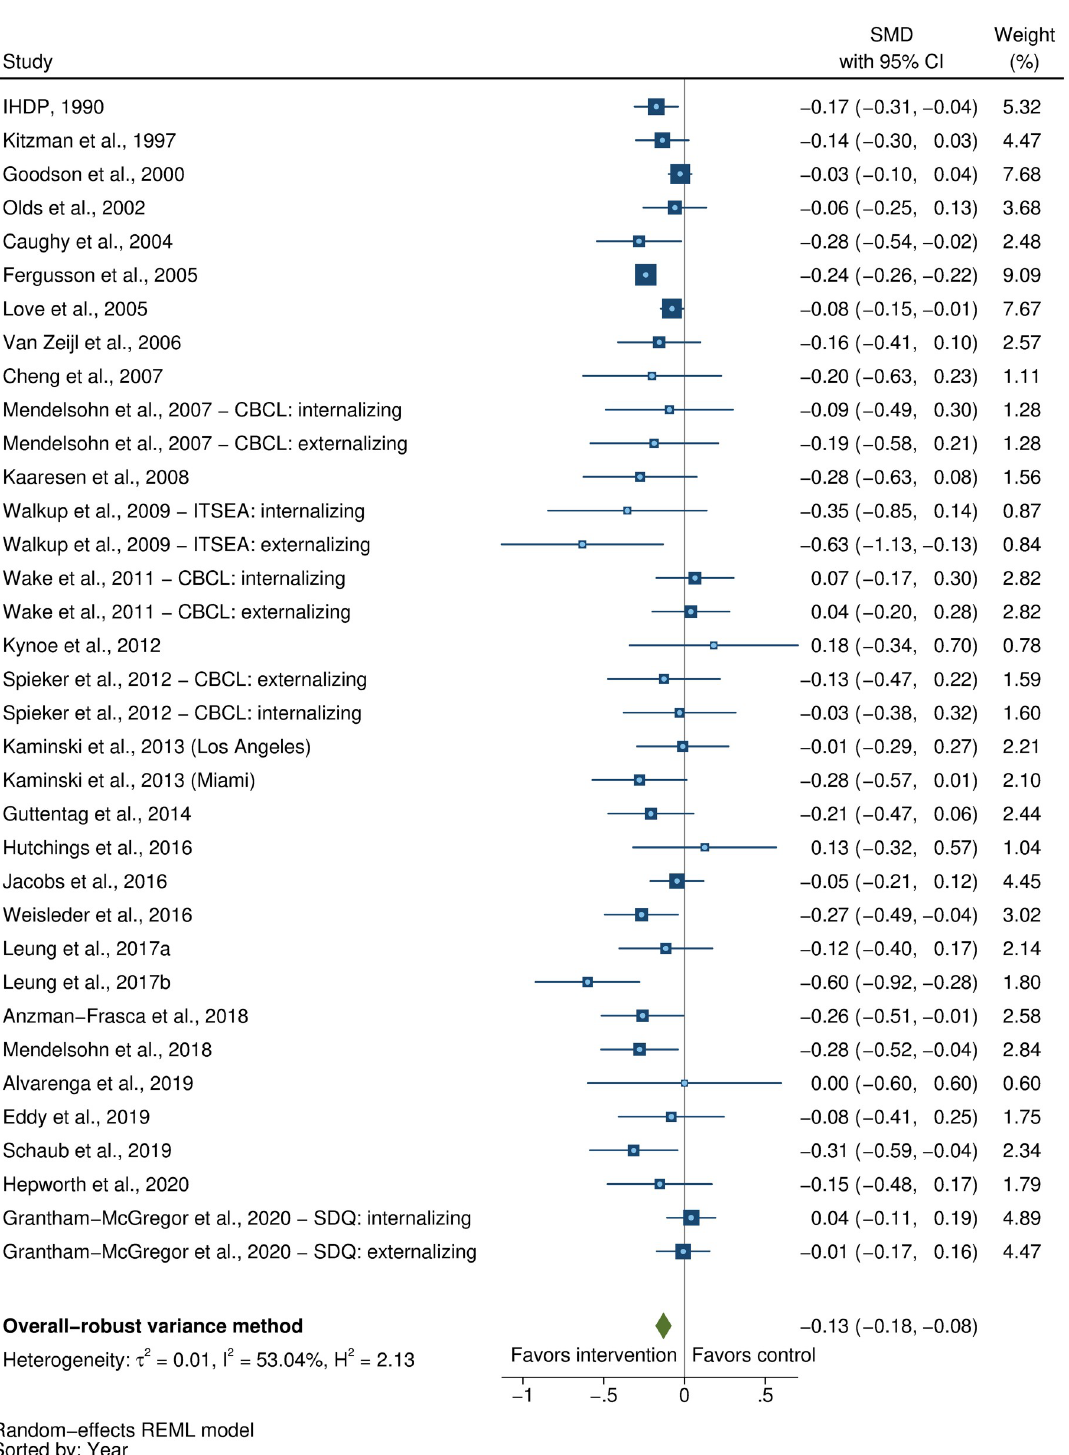
Fig 6. Forest plot for the effect of parenting interventions on behavior problems. Blue squares represent the SMD for each study, with the size of the square being proportional to the study weight. The whiskers extending from each side of the square represent the range of the 95% CI. The green diamond shows the overall pooled effect size using a random-effects model, which is centered at the point estimate and the diamond width representing the 95% CI. SMD, standardized mean difference.